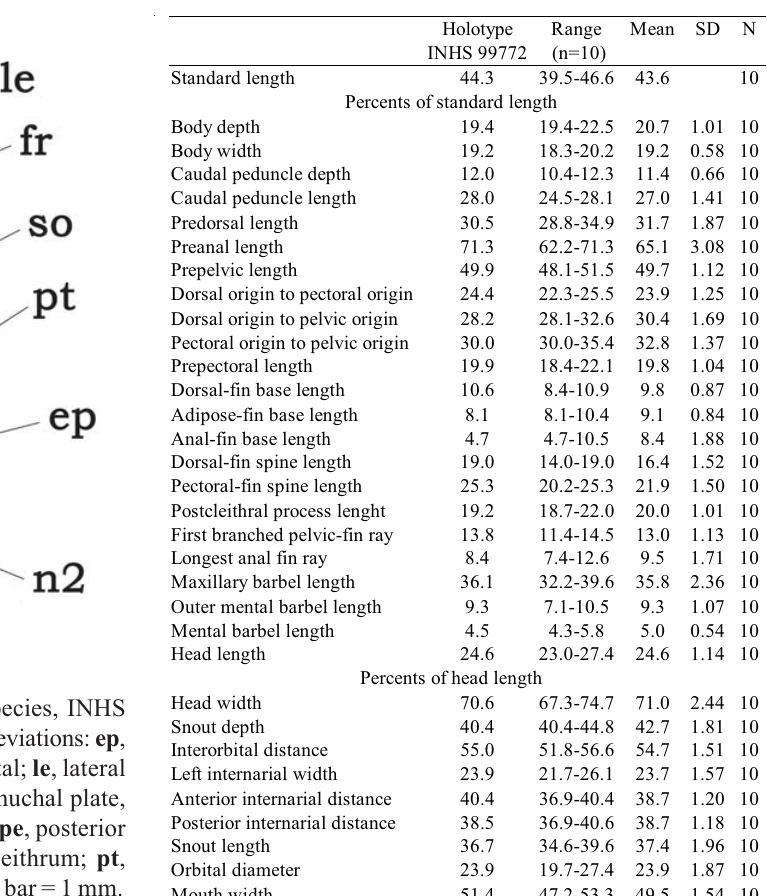
Table 10. Morphometric data for Tatia meesi . SD = standard deviation.